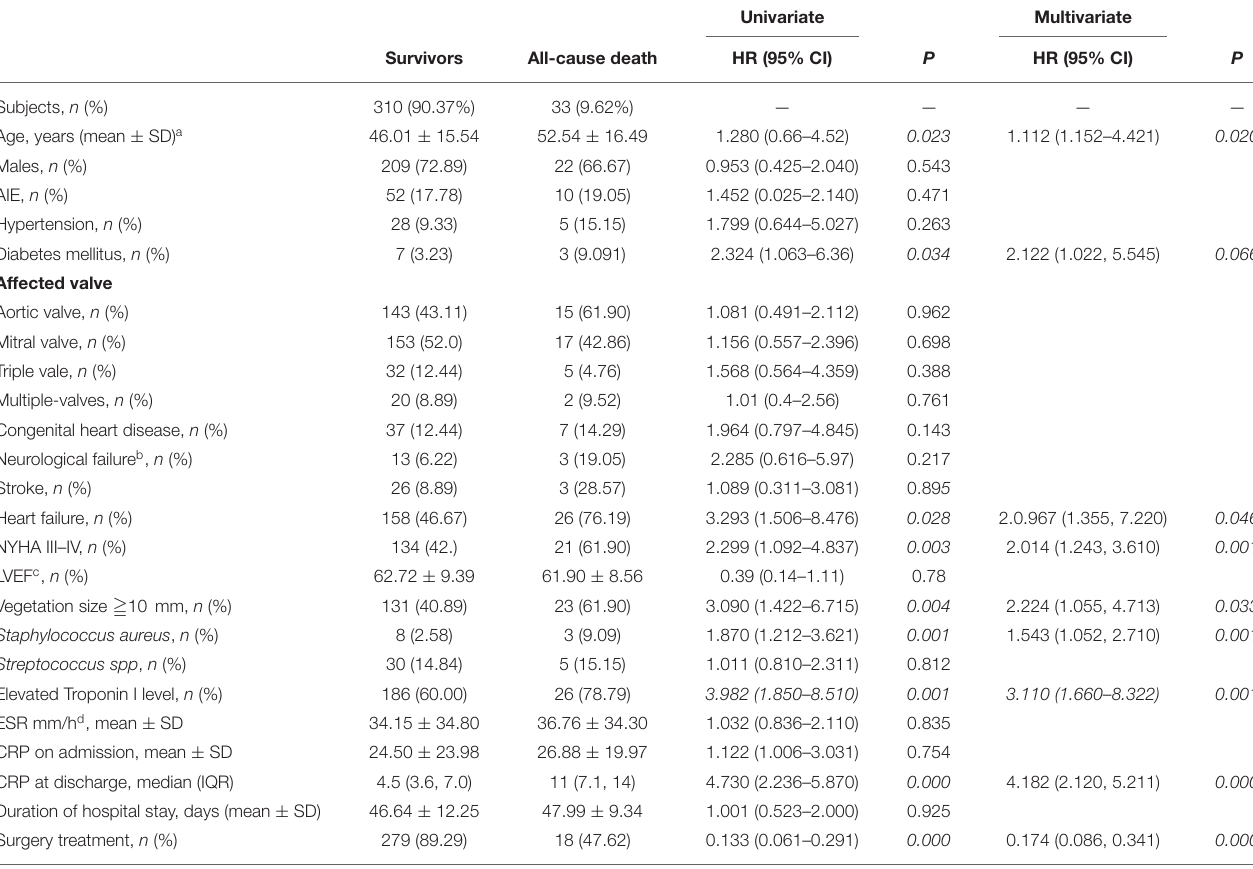
TABLE 2 | Univariate analyses and multivariate Cox proportional hazard of factors associated with 1-year mortality.